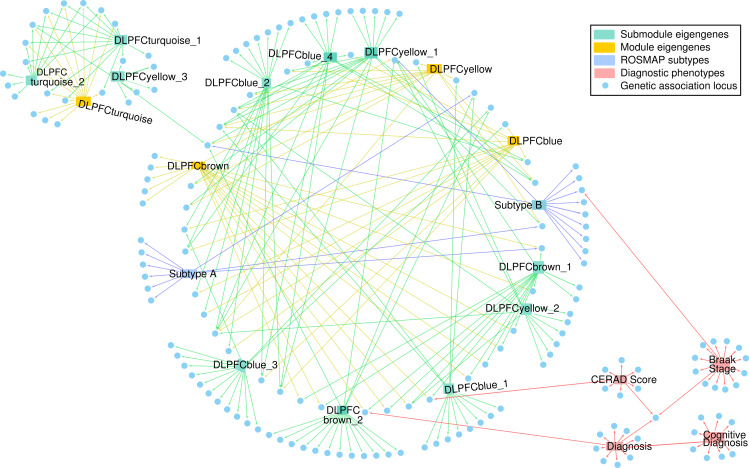
Network of endophenotypes and associated loci.We created a directed network describing the loci detected from the multiple analyses in this study. Blue nodes represent loci. Red nodes represent phenotypes. An edge from a phenotype to a genetic locus signifies that the locus is associated with that phenotype. Diagnostic phenotypes (red edges; right) were associated with some of the loci detected in this study. The module eigengenes (yellow edges), submodule eigengenes (green edges), and subtypes (blue edges) were associated with both overlapping and unique loci (center and left). A community of loci was associated with multiple submodules associated with microglia, endothelial cells, astrocytes, and oligodendrocytes (center). A small community of loci was associated with submodules related to proteostasis (left).